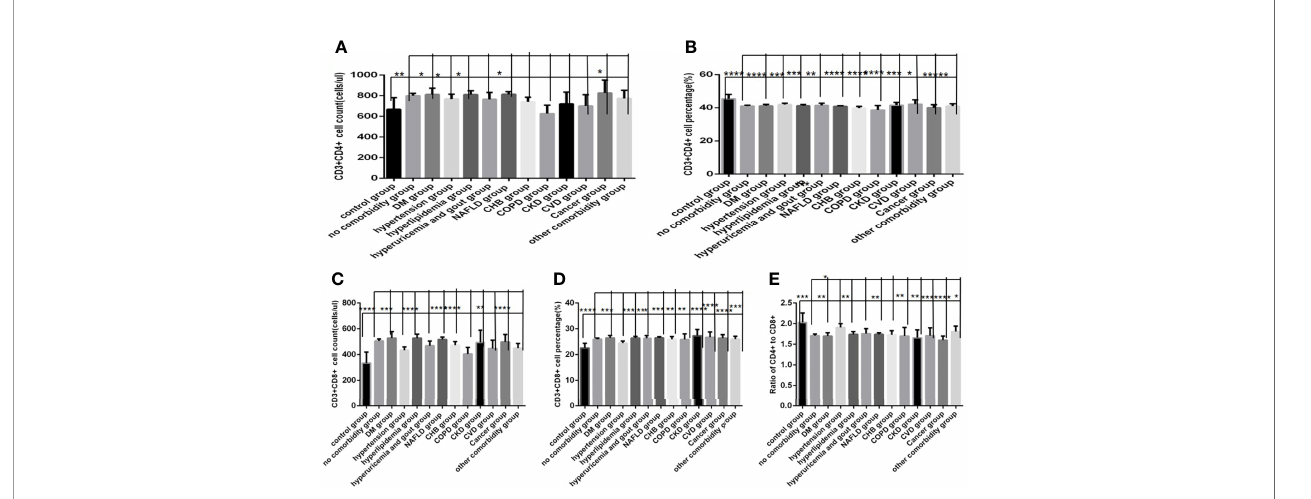
FIGURE 9 | Comparison of T lymphocyte subset counts and percentages among the control group, the no comorbidity group and each type of comorbidity group ( n =773; control, no comorbidity and each type of comorbidity group, n =55, 253, 82, 133, 47, 195, 63, 59, 15, 10, 11, 18 and 34 cases, respectively). Abbreviations: COVID-19, coronavirus disease 2019. NAFLD, nonalcoholic fatty liver disease. DM, diabetes mellitus. CHB, chronic hepatitis (B) COPD, chronic obstructive pulmonary disease. CKD, chronic kidney disease. CVD, cardiovascular disease. (A) CD3+CD4+ cell count. (B) CD3+CD4+ cell percentage. (C) CD3+CD8+ cell count. (D) CD3 +CD8+ cell percentage. (E) Ratio of CD4+/CD8+ cells. Unpaired one-way ANOVA was used for intergroup comparisons ( C , P < 0.01; B , D , P all < 0.05; A, P > 0.05). Unpaired t -tests were used for comparisons with the control group, and with the no comorbidity group, * P < 0.05, ** P < 0.01, *** P < 0.001, **** P <